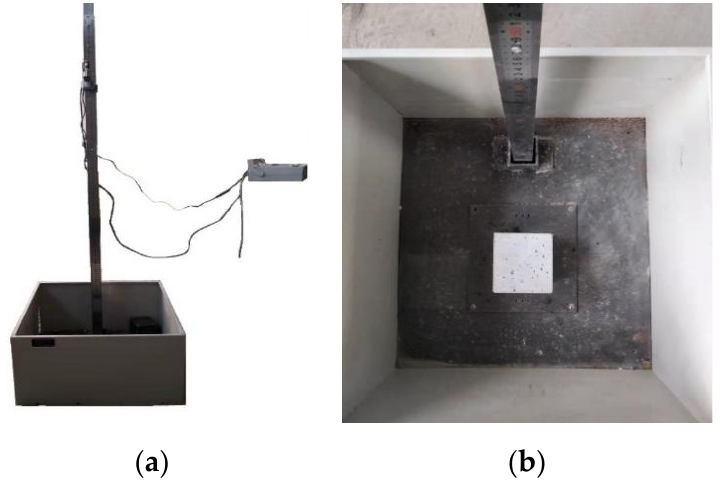
Figure 4. The testing apparatus for an impact resistance test. ( a ) Overall appearance; ( b ) Internal structure.